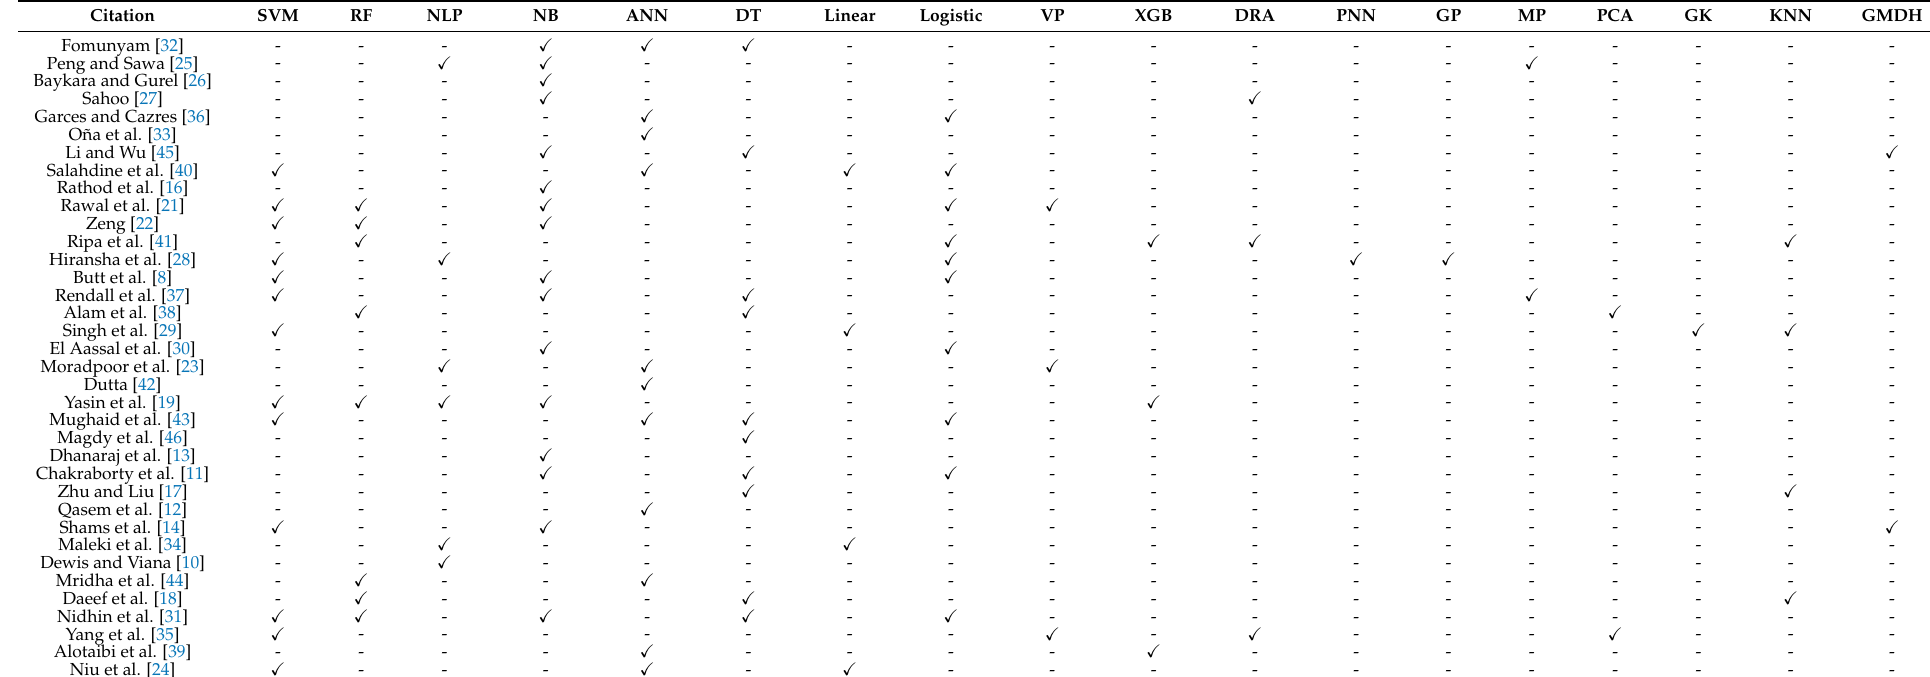
Table 5. ML algorithms utilised by various researchers to build BEC phishing detection